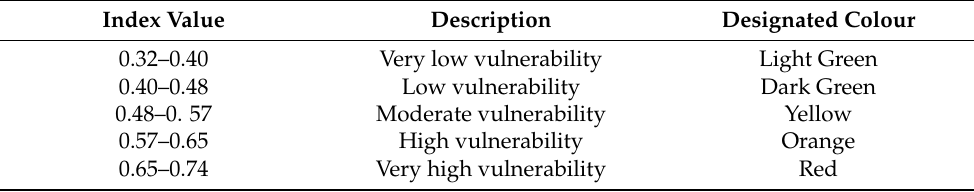
Table 3. Flood vulnerability index ranking for selected flood-prone communities in Kogi State.